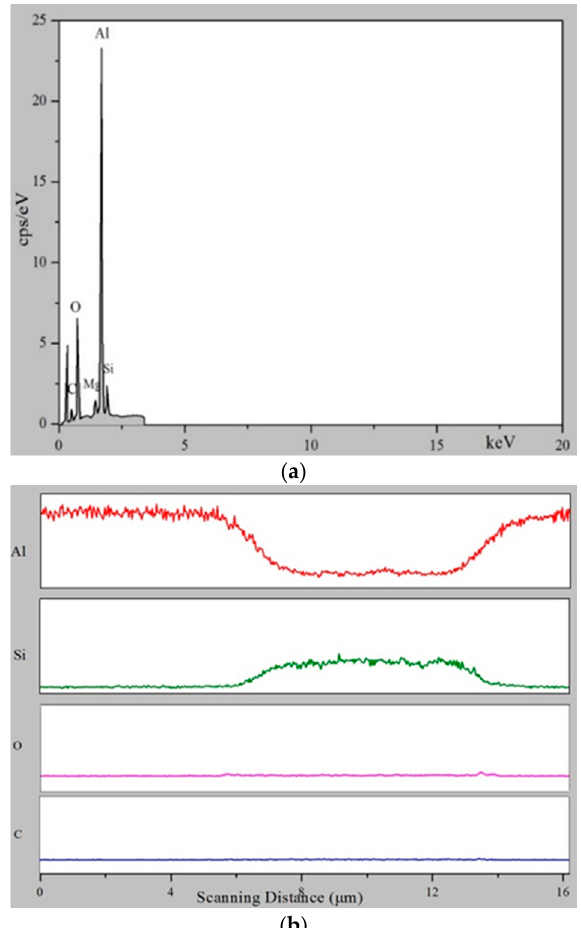
Figure 5. EDS-SEM analysis: ( a ) The analysis of point 1 of AA6061/10 vol.% N-SiC, ( b ) The analysis of line scanning 2 of AA6061/15 vol.% N-SiC sintered at 550 °C.